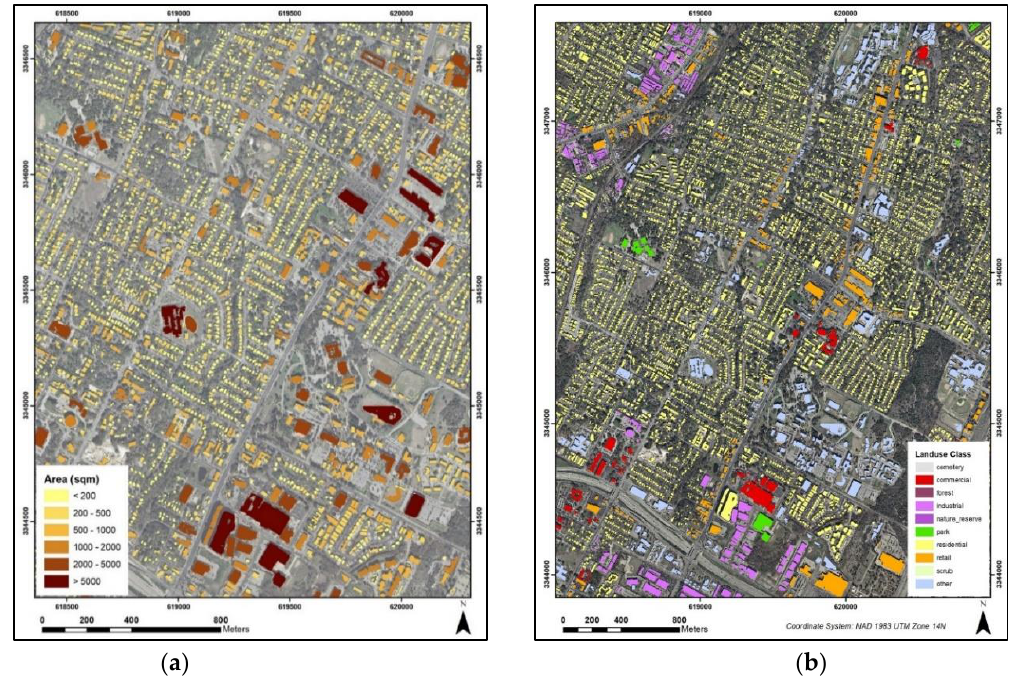
Figure 13. Maps created using the area and land use attributes of buildings in Austin: ( a ) Map showing calculated building area results in Austin; ( b ) Map showing added land use classes from OSM data to buildings in Austin.